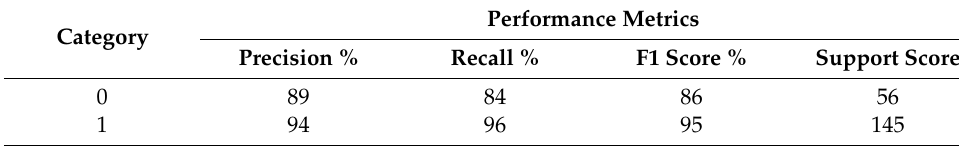
Table 10. The BiGR classification report analysis by the target category.